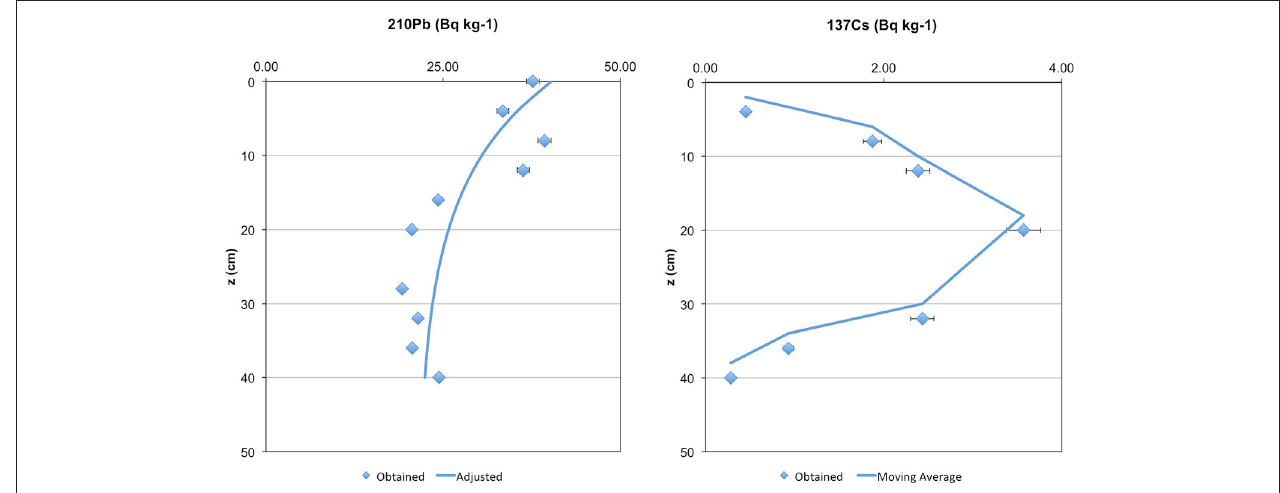
FIGURE 7 | Vertical distribution of 210xs Pb and 137 Cs for core CAN-N-01.